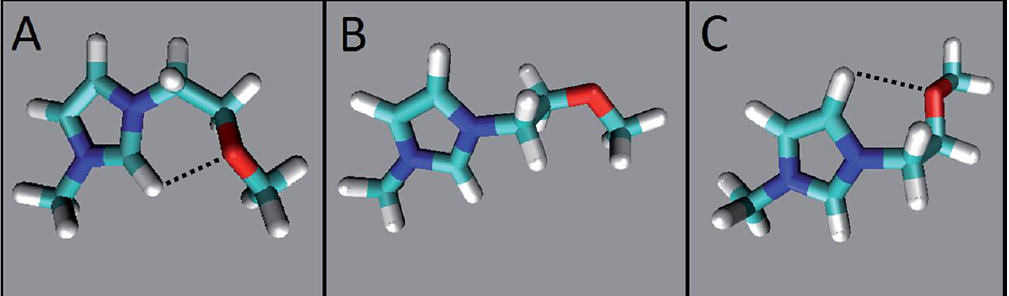
Figure 9. Molecular dynamics (MD) simulation-based snapshots of some limiting conformations of the cation of 1-(2-methoxyethyl)-3-methylimidazolium acetate in IL–water χ w = 0.67. The colors used to denote the atoms are red, cyan, white, and navy blue for oxygen, carbon, hydrogen, and nitrogen, respectively. The distances between the atoms are (in nm) O···H–C 2 = 0.239 ( A ); O···H–C 2 = 0.468 (( B ); open structure); O···H–C 5 – = 0.243 ( C ), reproduced from [75], with permission from RSC, 2017. To probe this hypothesis (deactivation of the H-bonding between the ether linkage and C 2 – H ), ILs with C 2 – CH 3 instead of C 2 – H were studied, namely, 1-butyl-2,3-dimethylimidazolium acetate (Figure 8c) and 1-(2-methoxyethyl)-2,3-dimethylimidazolium acetate (Figure 8d). Although this